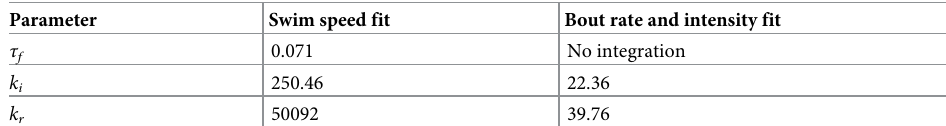
Table 2. Optimal parameters for the single process